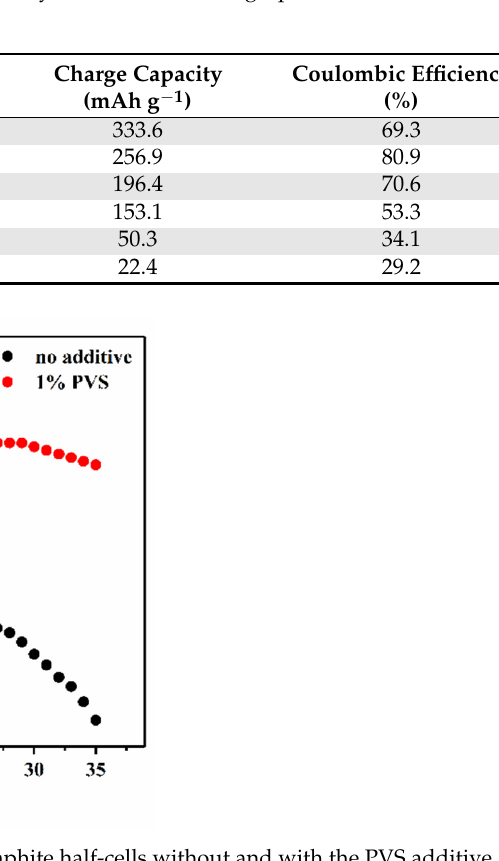
Figure 2. The capacity retention of the Li/graphite half-cells without and with the PVS additive after 35 cycles at the C-rate of 1 C and in the voltage range of 0.001–3